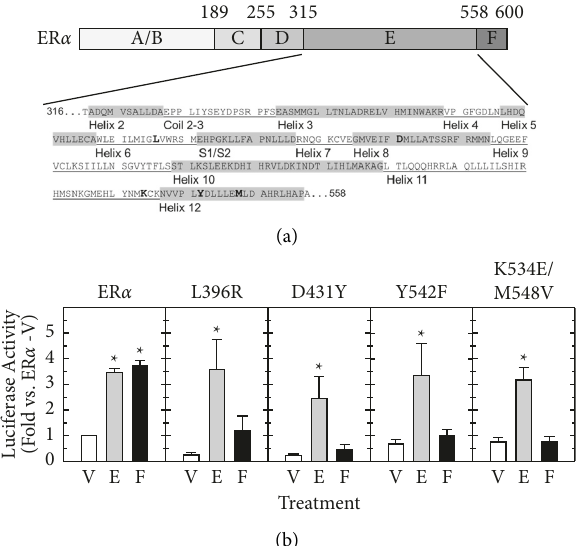
Figure 3: Forskolin-stimulated ER α transcriptional activity is mediated by specific residues located within the ligand-binding domain. (a) The upper panel shows rat ER α domain structure and the amino-acid sequence of the E domain (amino acids 316–558) with the indication of the alpha helixes (underlined or highlighted) and specific residues (bolded) required for forskolin-stimulated ER α transactivation. The helices correspond to those of the human ER α , and S1/S2 is a two-stranded antiparallel β -sheet as reported previously [75]. (b) HT22 cells were similarly transfected with a wild-type or mutated ER α expression vector with single (L396R, D431Y, or Y542F) or dual (K534E/M548V) amino-acid substitutions, followed by treatment of vehicle (V), estradiol (E, 10nM), or forskolin (F, 1 μ M) for 24h. The luciferase activity (mean ± SEM) was normalized and expressed as the fold stimulation over vehicle-treated cells transfected with wild-type ER α (as 1 fold) from three independent experiments with triplicate samples. ∗ , P < 0 . 05 vs. vehicle-treated groups (V) with the same ER expression